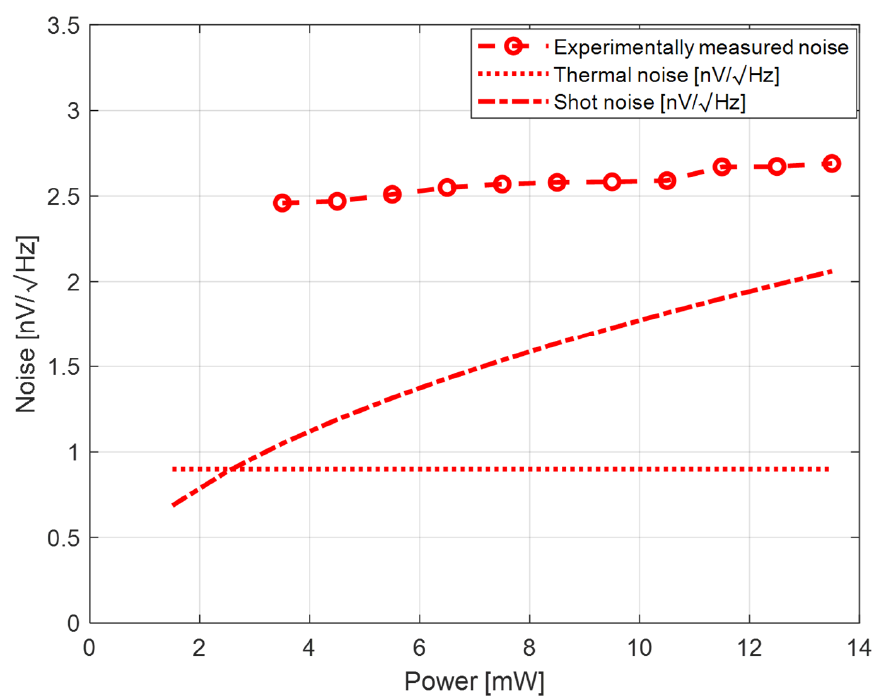
Figure 5. Calculated noise and experimentally measured noise as a function of laser power in the range from 1.5 to 13.5 mW with the steps of 1 mW.